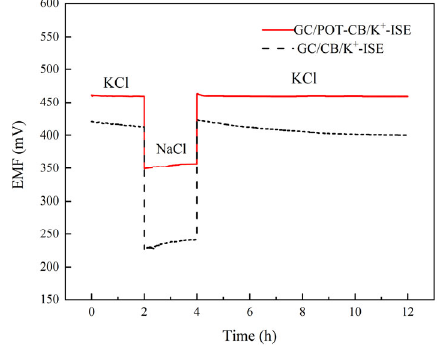
Figure 6. Water layer test diagram.